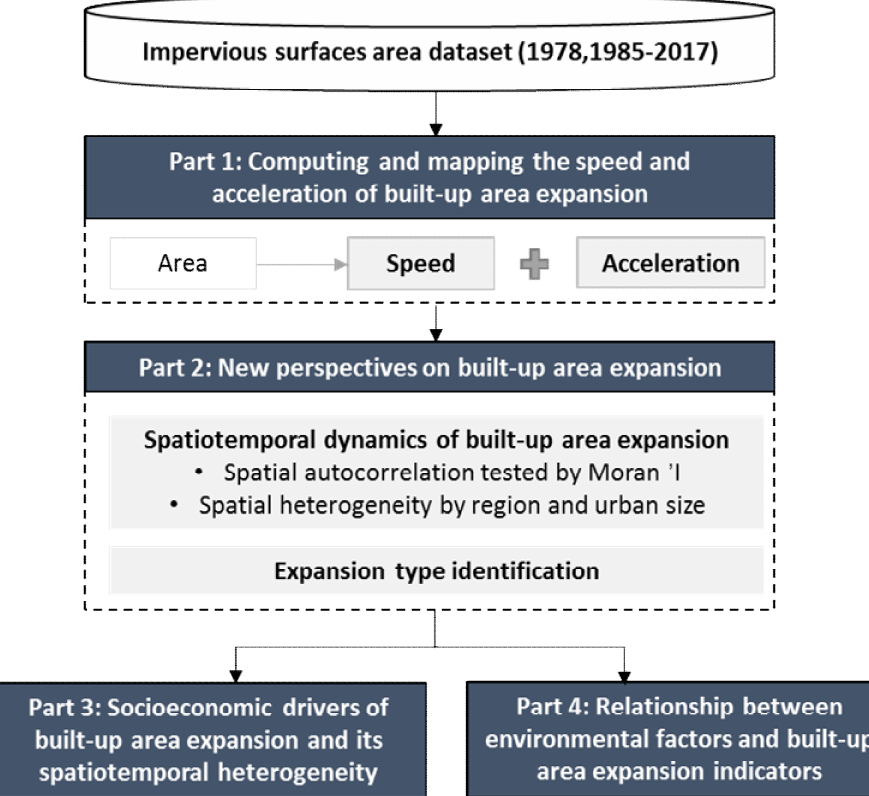
Figure 1. The workflow of the mapping and analysis process.